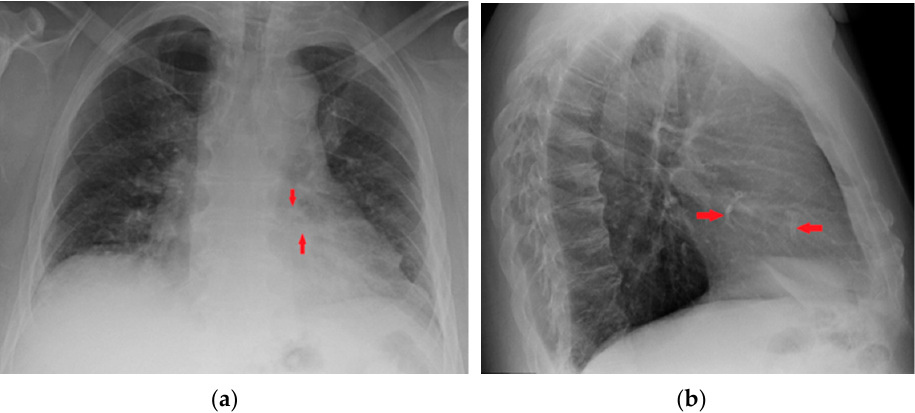
Figure 19. Coronary artery stents (red arrows), barely visible on the PA projection ( a ), can be better appreciated on the LL view ( b ).